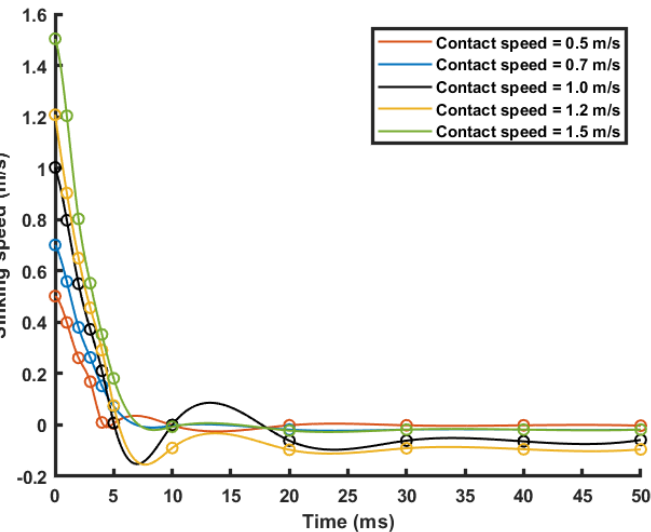
Figure 13. The speed versus time of the benthic lander sinking into the sediment.